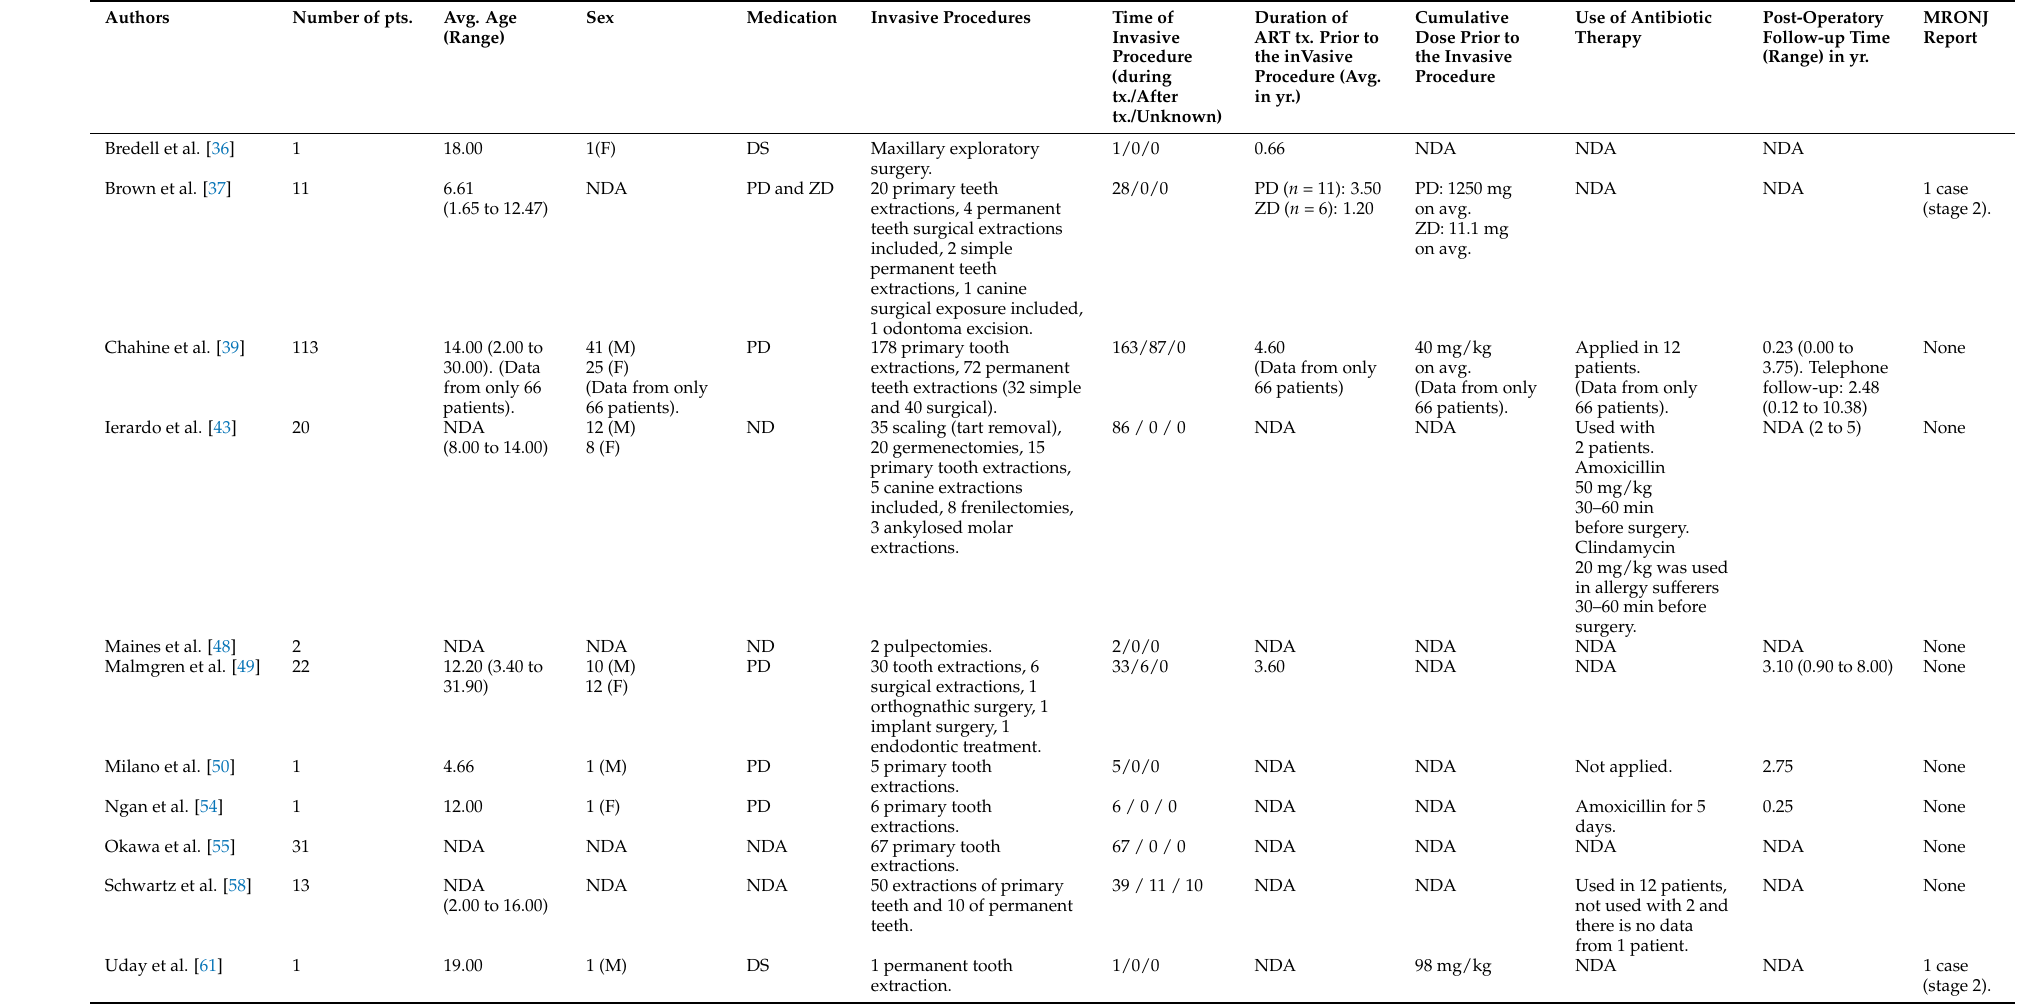
Table 3. Distribution of data from patients undergoing invasive dental procedures and MRONJ